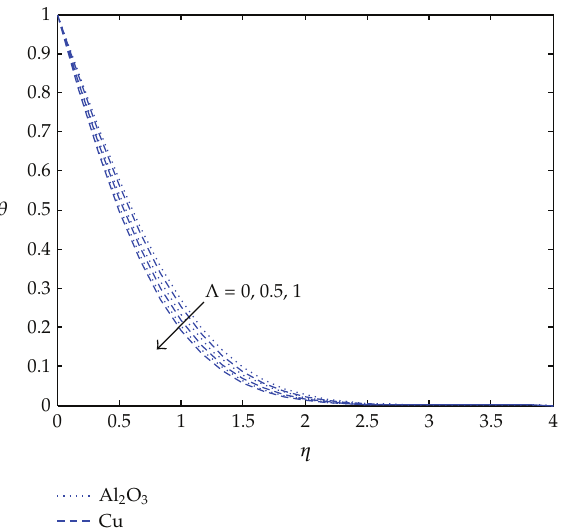
Figure 5: Variation of dimensionless temperature for di ff erent values of ∧ (cid:5) Pr (cid:8) 6 . 2, ψ (cid:8) 0 . 1, m (cid:8) 1, ξ (cid:8) 0 . 1, p (cid:8) 1 (cid:6)